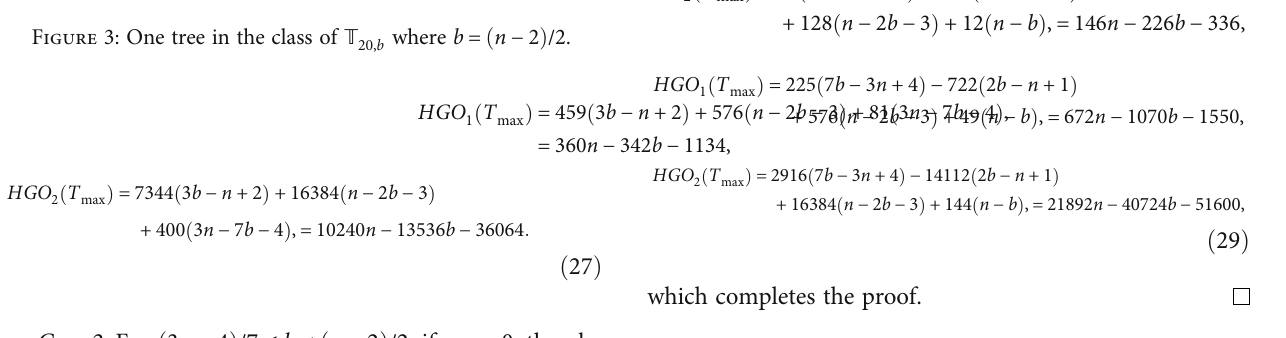
Figure 3: One tree in the class of T